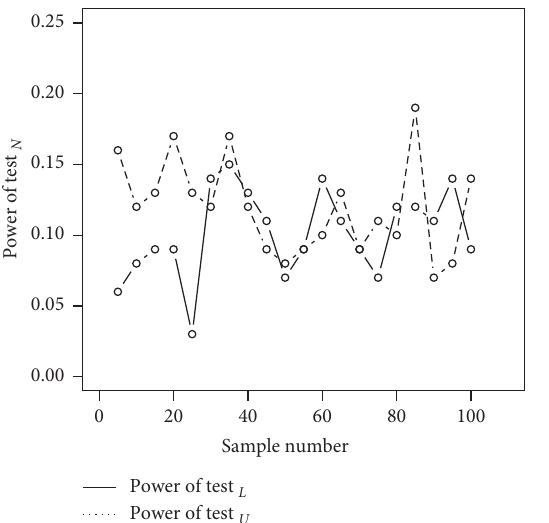
Figure 1: Power curve for the neutrosophic Weibull distribution.